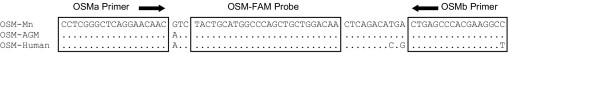
Primer location and specificity for the OSM QPCR assay to detect cell copy number. Corresponding sequences from the third exon of the OSM gene from human, African green monkey (AGM) and pig-tailed macaque (Mn) are aligned with the positions of the OSM primer set and probe indicated. The OSMa primer and OSM-FAM probe were derived from the sense strand, as shown, while the OSMb primer was derived from the antisense strand.